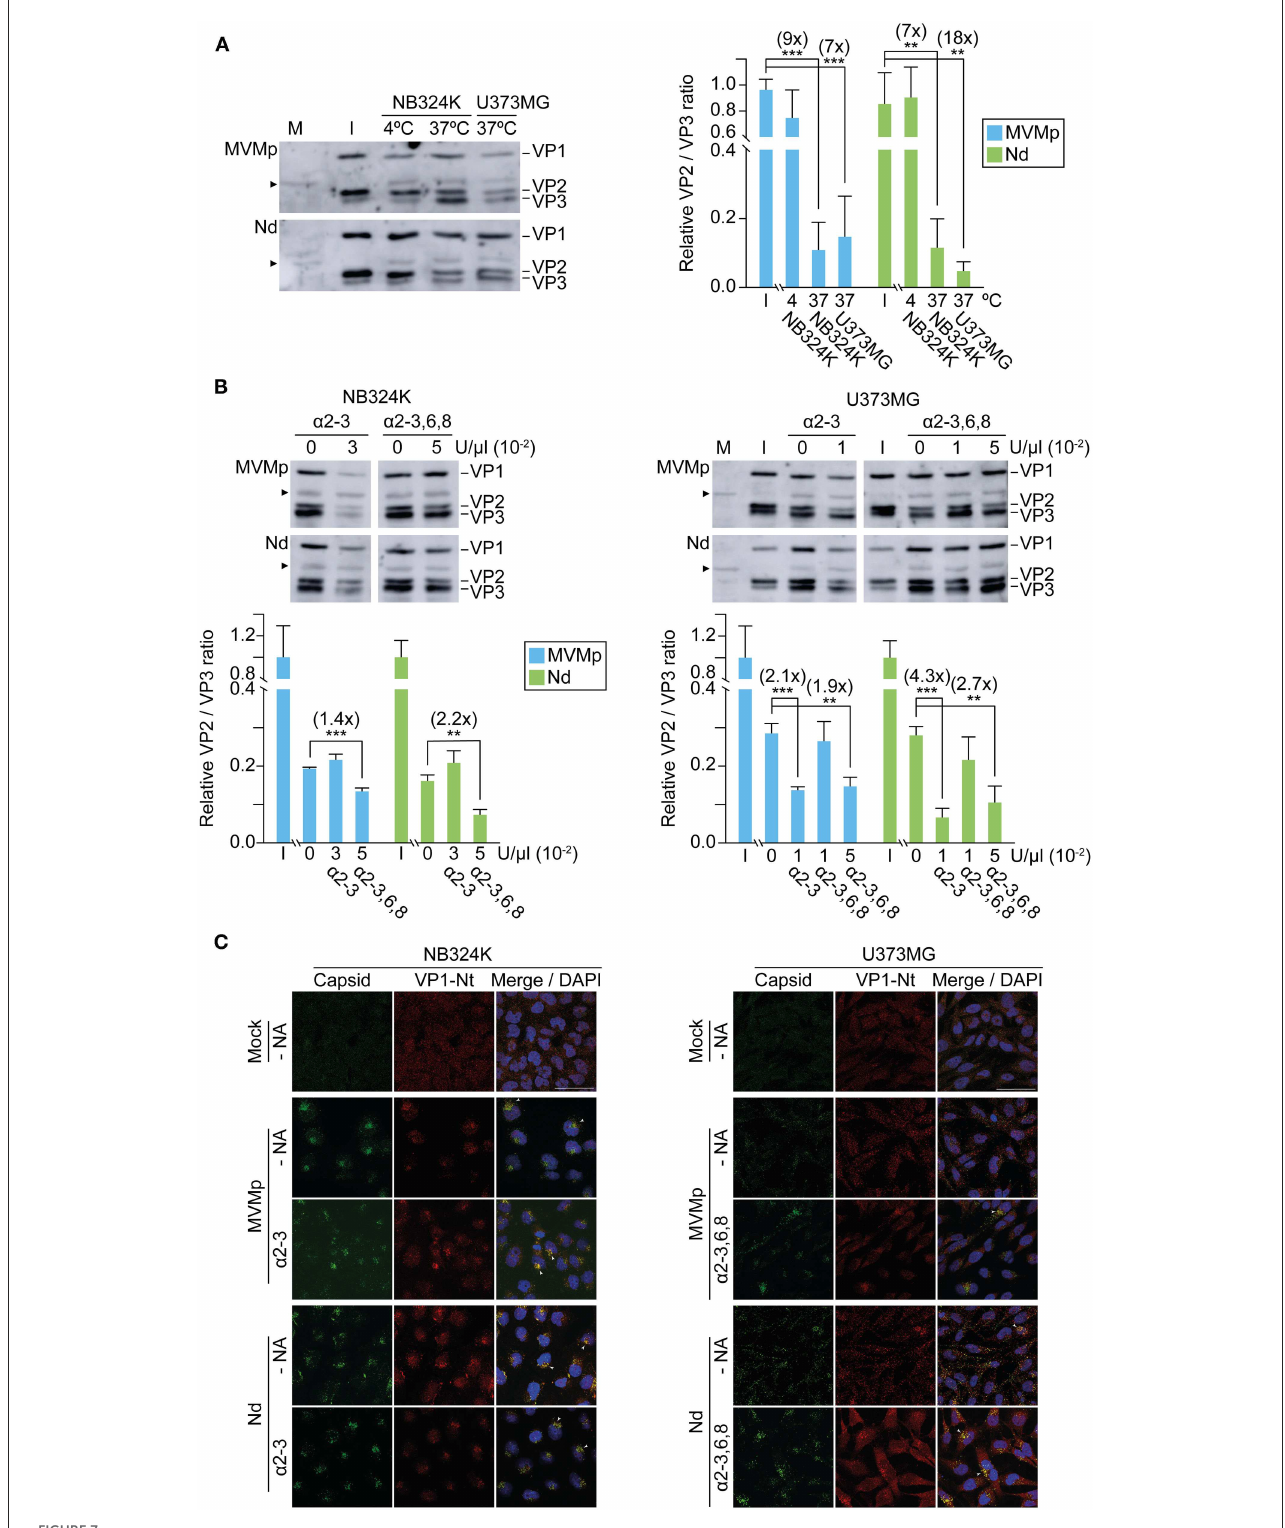
FIGURE7 Capsid binding to surface sia moieties influences the extent of endocytic VP2 cleavage and VP1 externalization. (A) Different VP2 to VP3 processing of MVMp and the Nd chimera in NB324K and U373MG cells. Left: Representative Western blot analysis of the VP2 to VP3 processing at 4 hpi. Viral structural proteins (VP1, VP2, and VP3) are indicated. Right: Quantitative values of the VP2/VP3 processing in each cell type. (B) Influence of cell type-dependent sia contacts in VP2/VP3 processing at 4 hpi. Upper: Representative Western blot analysis of the VP2 to VP3 processing in the presence of the indicated U/ µ l of NA. Below : VP2/VP3 ratio obtained under the indicated NA treatments. Numbers in parenthesis are fold increase. Independent viral stocks with distinct VP2/VP3 ratio were used in the experiments outlined in (A, B) . Values were obtained by densitometry and normalized with respect to the VP2/VP3 ratio of the respective input virions (I) in (A) , or with respect to the untreated samples in (B) . Shown are the means with standard error from three to five independent experiments. Significance: ** p < 0.01; *** p < 0.001. (C) Sia contacts influence the endosomal exposure of VP1-Nter. Cells were inoculated with purified virions and subcellular localization of viral capsids (B7-mAb antibody), and VP1-Nt exposure at 4 hpi was determined by confocal IF. Viral inoculations and NA treatments were performed as in Figure 6. Arrowheads mark VP1-Nt staining in virions clustering in endosomes. Scale bar, 50 µ